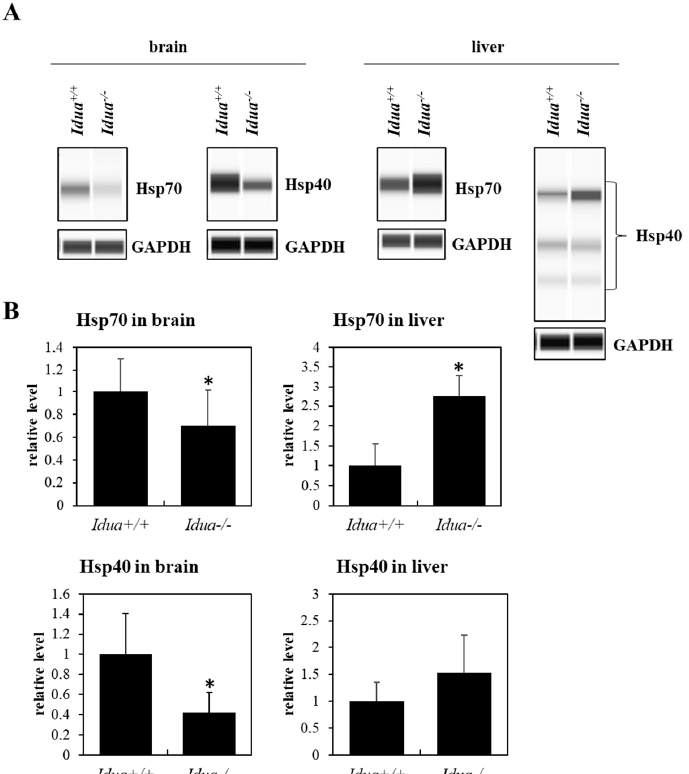
Figure 4. Hsp70 and Hsp40 levels in brain and liver tissues of MPS I mice. Western blotting analyses (with GAPDH as a loading control) of the abundance of Hsp70 and Hsp40 in the brains and livers of MPS I ( Idua − / − ) and control ( Idua +/+ ) mice. Representative blots are shown ( A ), and quantitative analyses (based on densitometry) from 6 animals in each group, with error bars representing SD, are demonstrated ( B ). Asterisks indicate statistically significant differences (at p < 0.05 in two-way ANOVA and post hoc Tukey’s test) relative to control ( Idua +/+ ) mice.